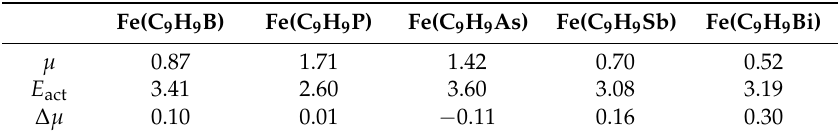
Table 4. Dipole moment ( µ , D) of isolated metallocene molecules with an eclipsed configuration; activation energy ( E act = E transition state − E ground state , kJ/mol) and dipole moment difference ( ∆ µ = µ transition state − µ ground state , D) between the transition state and the ground state. The number of the 3 d electrons rest on Fe is 6, and the magnetic moment of the isolated molecules is